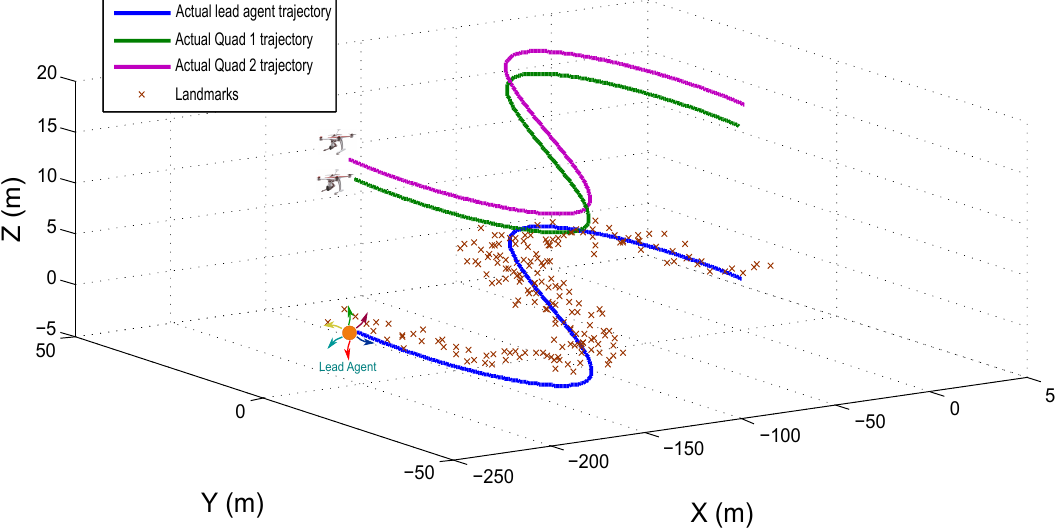
Figure 8. Simulation environment and trajectories followed by the lead agent, the Quad 1 and the Quad